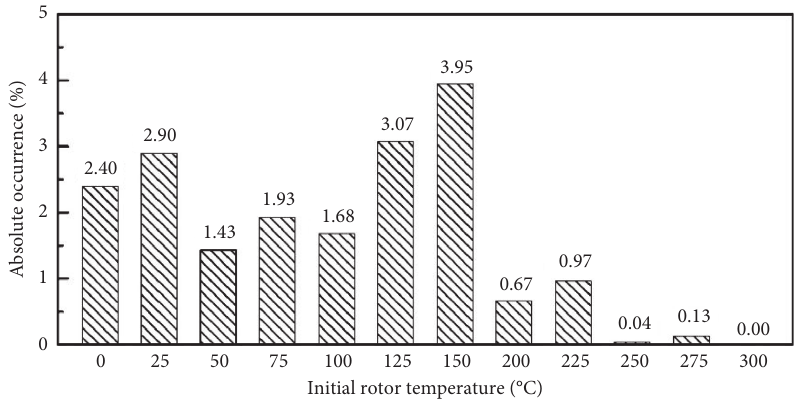
Figure 6: Absolute noise occurrence for different initial rotor temperatures. Table 4: Direct effects of working conditions on